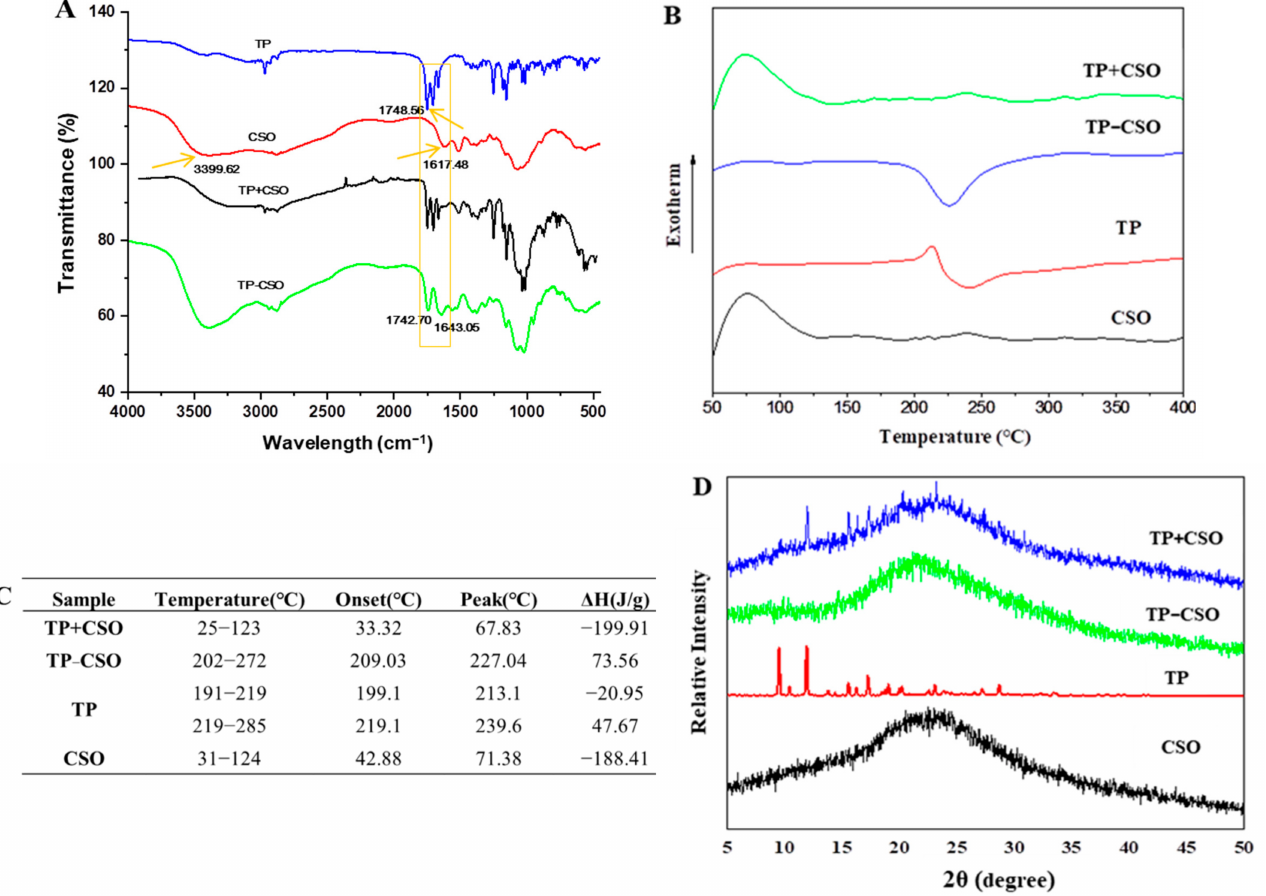
Figure 1. FTIR spectra of TP, CSO, TP+CSO, TP-CSO ( A ); DSC thermogram patterns of TP, CSO, TP+CSO, TP-CSO ( B ); DSC data of TP, CSO, TP+CSO, and TP-CSO ( C ); XRD diffraction patterns of TP, CSO, TP+CSO, and TP-CSO ( D